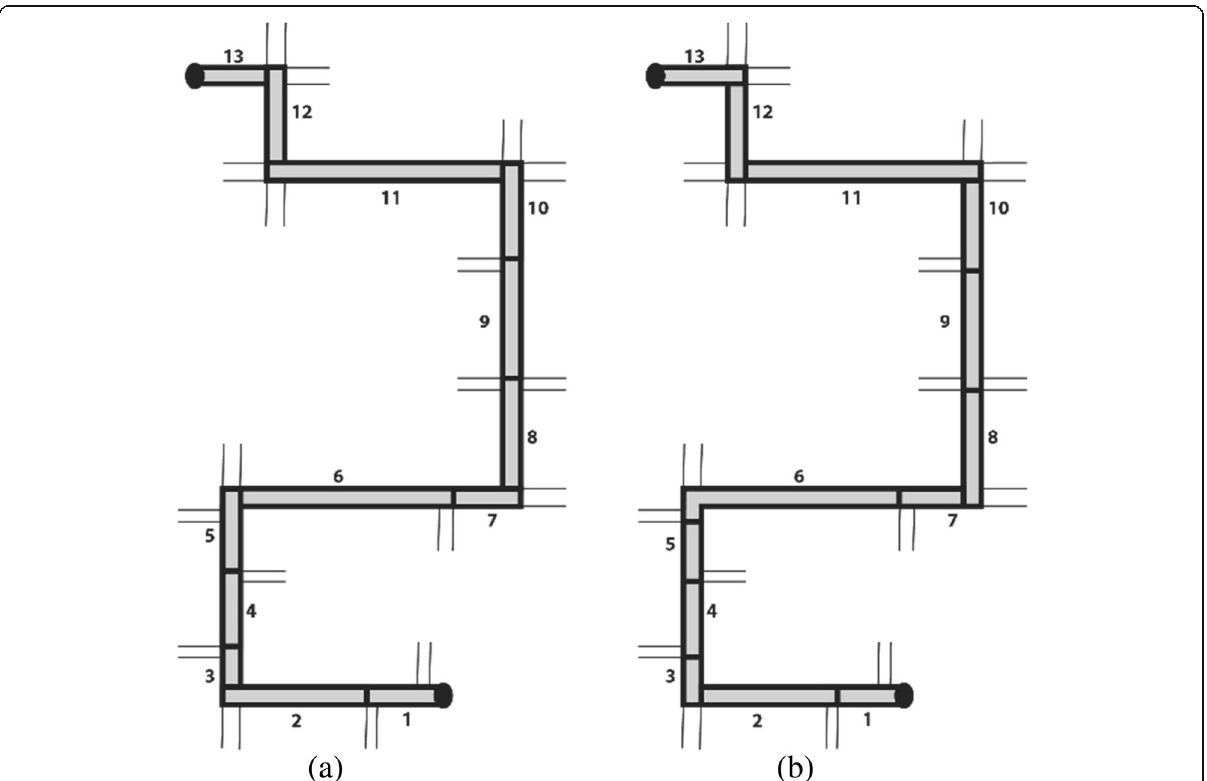
Fig. 4 Spatial segmentation of the route (schematic) into 13 segments. Each segment represents the spatial context of approaching a decision point in walking direction including the relevant intersection. Spatial segmentation of the route for Phase 1 ( a ) and Phase 2 ( b